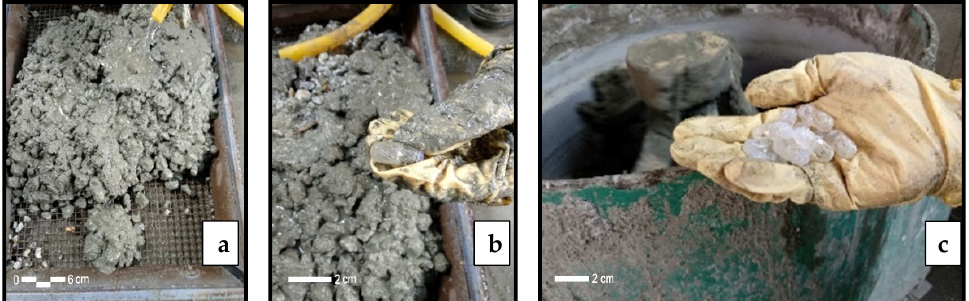
Figure 4. ( a ) Removing cement paste from aggregates and capsule, ( b ) capsule surrounded within fresh concrete mixture, and ( c ) sample of physical inspection on capsule defects.